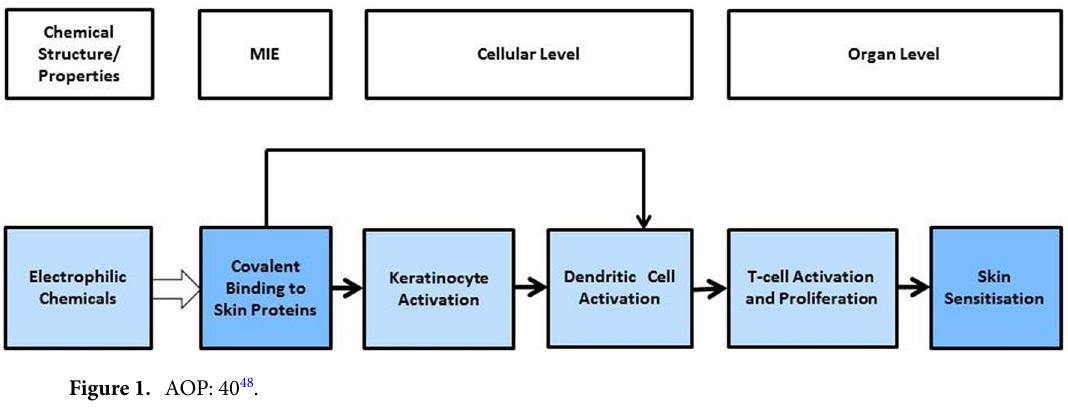
Figure 1. AOP: 40 48